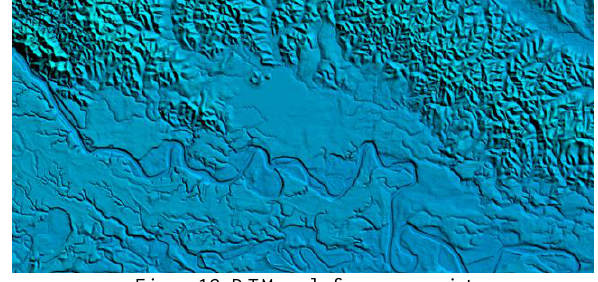
Figure 12. DTM only from